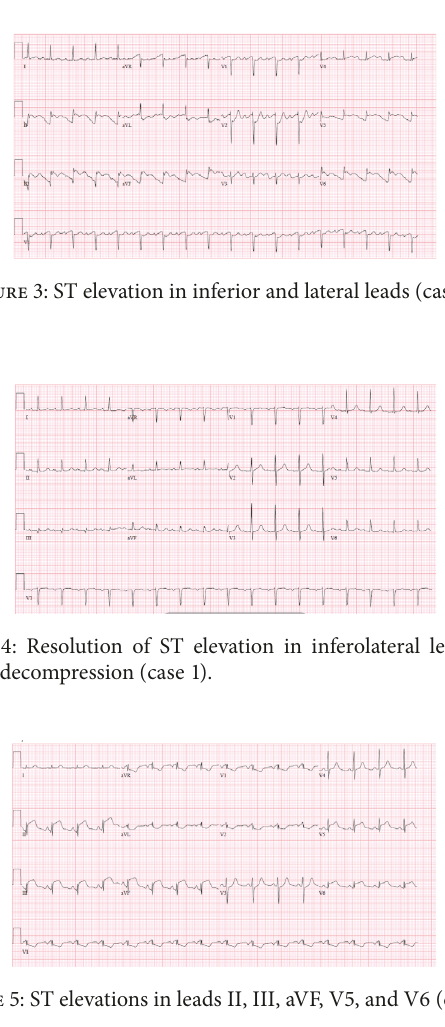
Figure 2: Dilated multiple loops of proximal small bowel with collapsed distal loops of small bowel consistent with small bowel obstruction (case 1).